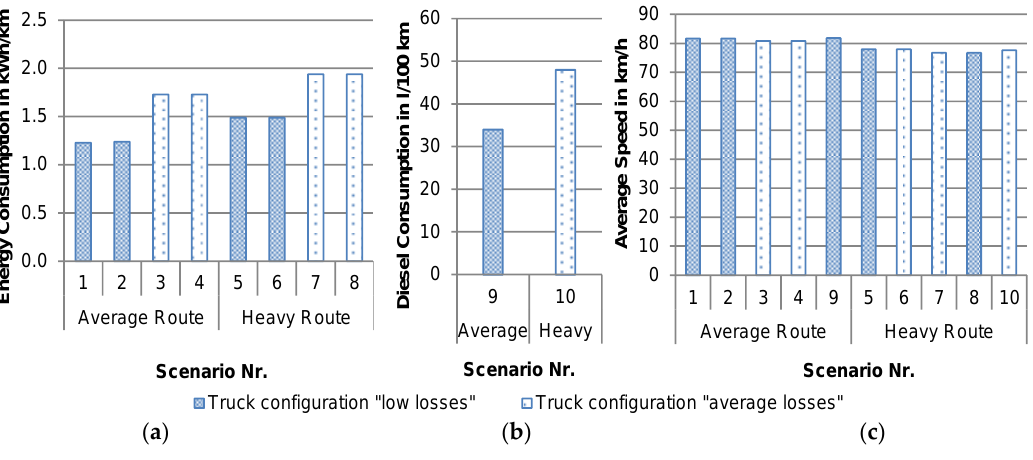
Figure 11. Simulation results: ( a ) Energy consumption of battery electric truck; ( b ) fuel consumption of diesel truck and ( c ) average speed for considered transportation scenarios and truck configurations.